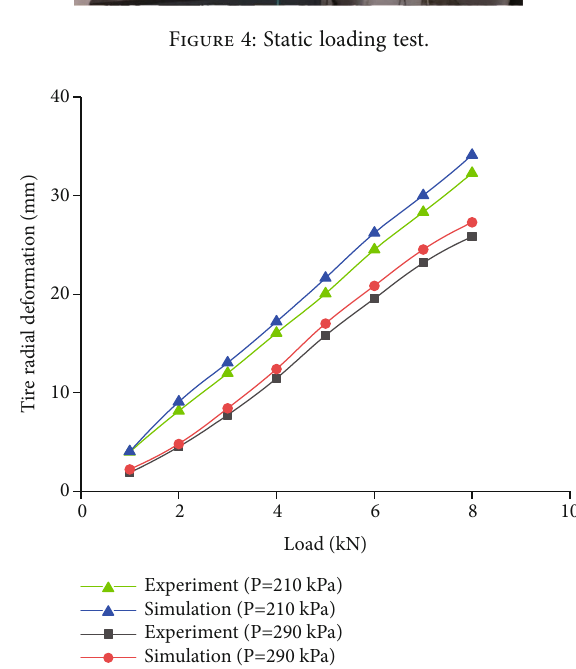
Figure 5: Load-radial